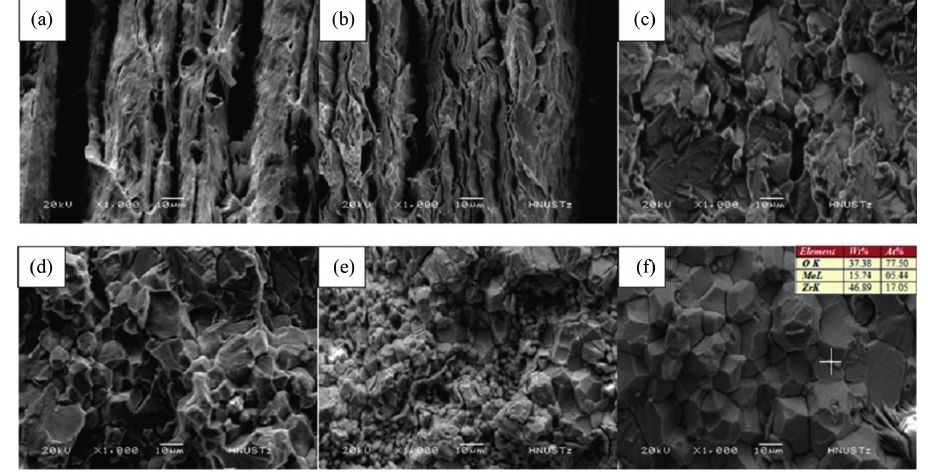
Figure 9: Tensile fracture topography of Mo-0.1Zr alloy after different temperatures of annealing (a) unannealing (b) 800°C (c) 1,000°C (d) 1,100°C (e) 1,200°C (f)